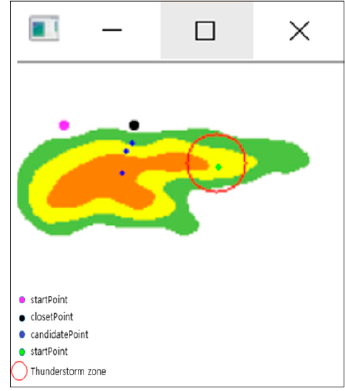
Figure 14. Each point expressed on the contour.